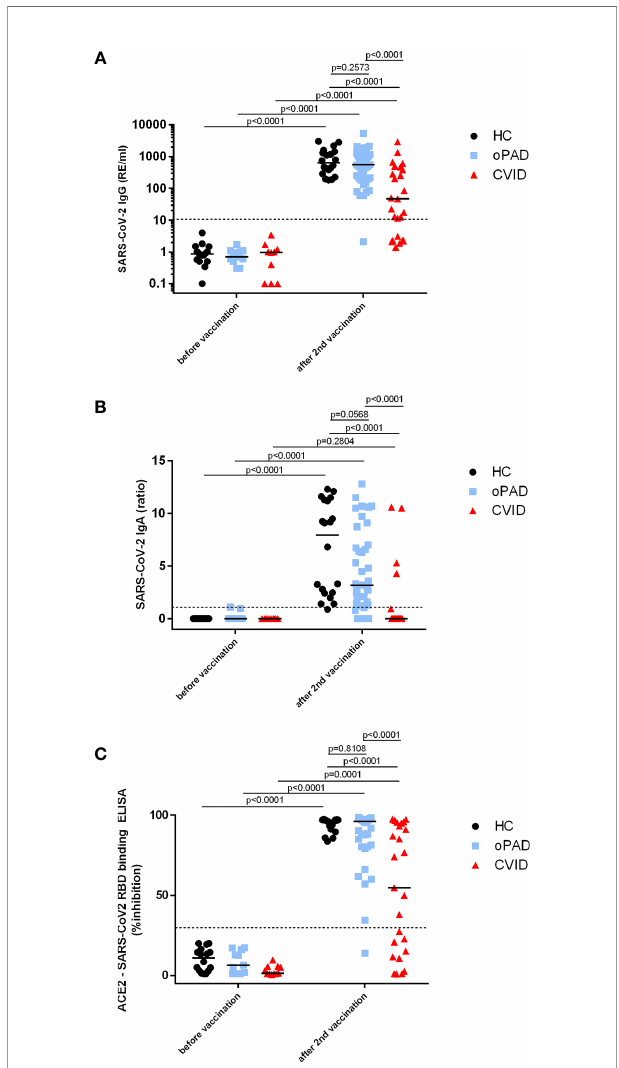
FIGURE 2 | Antibodyresponse following asecond BNT162b2 mRNA vaccination in patients with CVID and oPAD. Serum IgG (A) and IgA (B) antibodies against spike protein of SARS-CoV-2 were examined by ELISA in patients with CVID, patients with milder forms of primary antibody de fi ciency (other predominantly antibody de fi ciency, oPAD) andhealthycontrols (HC) before COVID-19 vaccination and after the second vaccination with the P fi zer-BioNTech COVID-19 vaccine BNT162b2 (Comirnaty). Results for IgG antibodies are expressed as relative units (RE)/ml, the dotted line indicates 11 RE/ml that were used as the cutofffor positivity. Semiquantitative measurements of IgA antibodies are expressed as the ratio between the extinction of patient samples and the extinction of a calibrator provided with the kit; the dotted line indicates a ratio of 1.1 that was considered as the cutofffor positivity. Surrogate virus neutralizing antibodies (C) were assessed by testing the ability of serum antibodies (irrespective of isotype) to inhibit the interaction between recombinant SARS-CoV-2 receptor- binding domain and angiotensin-converting enzyme 2 using a blocking ELISA. Results are expressed as percent inhibition; the dotted horizontal line depicts 30% inhibition used as the cutofffor positive SARS-CoV-2 neutralizing antibody. Statistical differences between the two groups depicted in the fi gure and were determined with a non-parametric two-tailed Mann – Whitney U-test (Kruskal – Wallis H test for all groups: p <0.0001), the median is represented by a horizontal